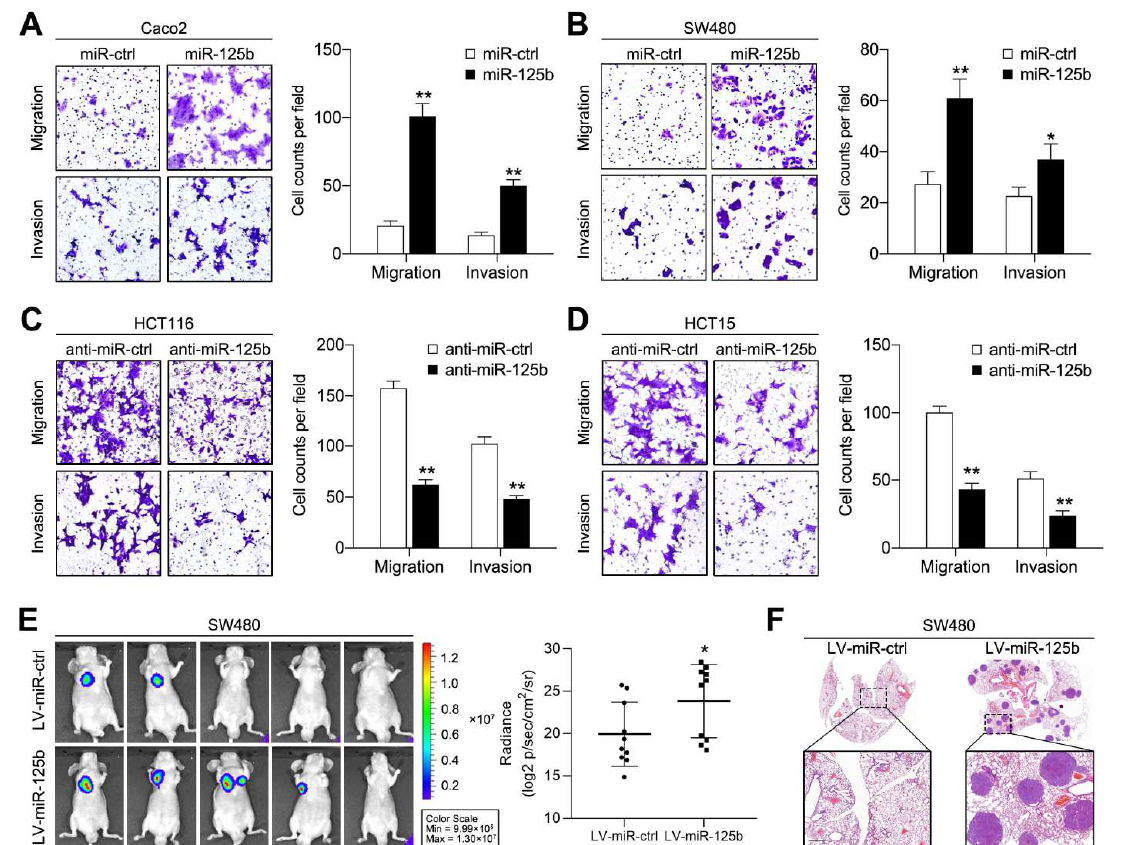
Figure 2. miR-125b promotes CRC cell migration, invasion and metastasis. ( A , B ) Transwell migration and invasion assays using Caco2 ( A ) and SW480 ( B ) cells transfected with miR-125b mimic or control mimic (miR-ctrl). ( C , D ) Transwell migration and invasion assays using HCT116 ( C ) and HCT15 ( D ) cells transfected with miR-125b inhibitor or control inhibitor (anti-miR-ctrl). Representative images are shown on the left, and quantification of 5 randomly selected fields is shown on the right. ( E ) Representative bioluminescence images of mice ( n = 10) after tail vein injection of SW480 cells infected with lentiviral miR-125b (LV-miR-125b) or negative control (LV-miR-ctrl). The signal intensity was detected and calculated. ( F ) Representative hematoxylin and eosin (H&E)-stained lung tissue sections of mice from the indicated groups. Scale bars represent 500 μm. * p < 0.05, ** p < 0.01 by the Student’s t -test.